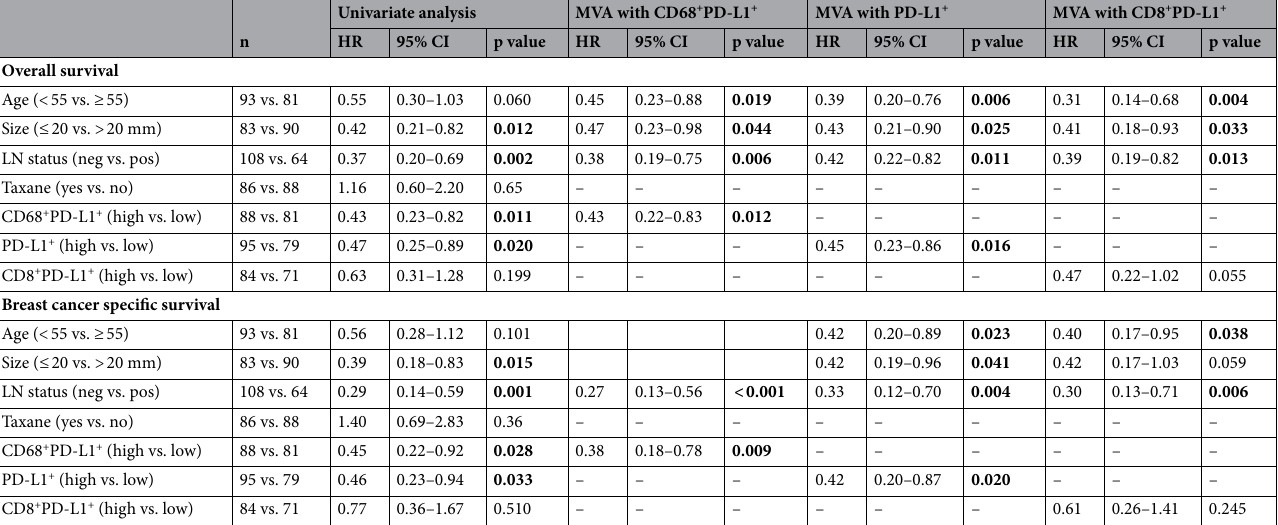
Table 4. Survival models for CD68 + PD-L1 + and CD8 + PD-L1 + in patients who received chemotherapy. LN, lymph node; MVA, multivariate analysis. Univariate and multivariate Cox regression models using a p value threshold of 0.05 for statistical significance, which are labelled in bold; [–] indicates the immunophenotype was not